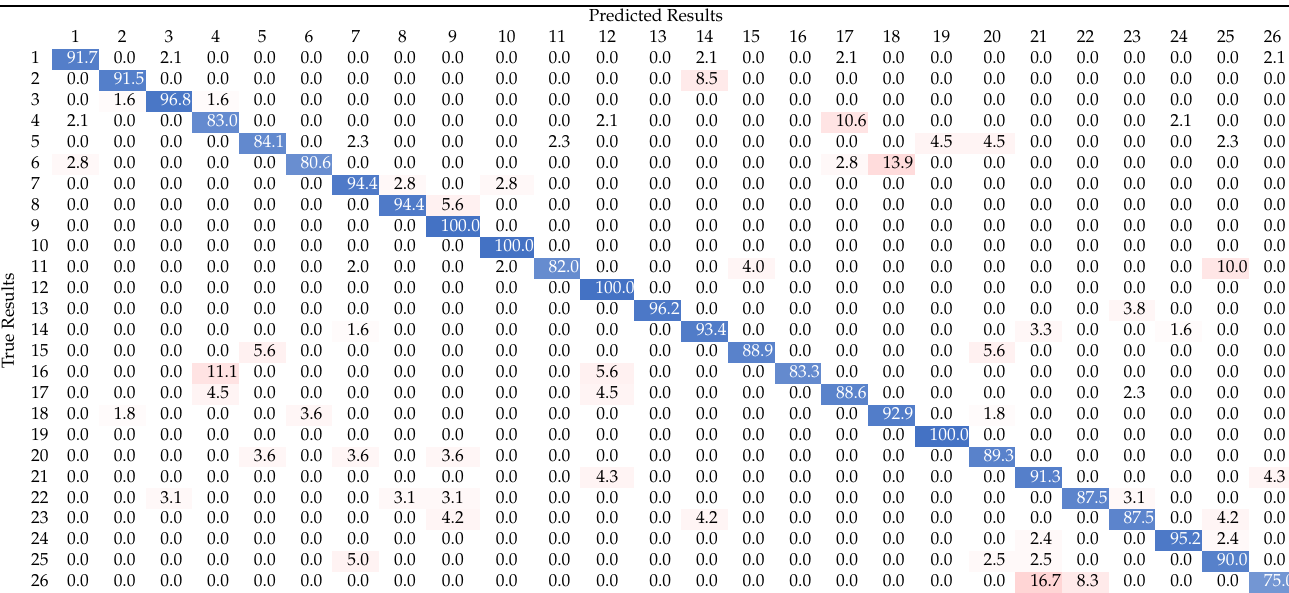
Table 3. Confusion matrix of the DenseNet121 model for the classification of the 26 Amazon parrot species. Numbers from 1–26 indicate the 26 Amazon parrot species (shown in Table 1). The rows contain the actual species, and the columns contain the species predicted by the models. The prediction results for the models are shown as percentage values. The diagonal values indicate the correct predictions, with the other values being the incorrect predictions. The correct predictions are shaded in blue, and the incorrect predictions are in red. The deeper the blue, the higher the value of the correct prediction; the deeper the red, the higher the value of the incorrect